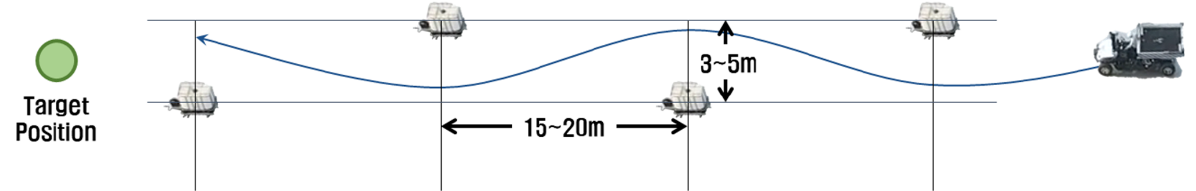
Figure 10. Concept diagram for avoiding multiple obstacles.